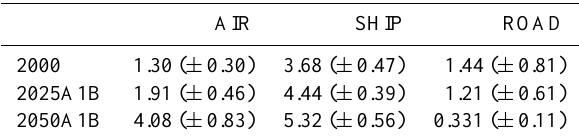
Table 3. Relative changes (%) in methane lifetime (integrated up to 50hPa) due to a 5% decrease in traffic emissions. Values are global annual averages given relative to the BASE simulation, and are scaled to 100% by multiplying with 20. Both the mean of the six models and the standard deviations (indicating the spread of the models) are given. Note that this table does not include the feedback effect of methane changes on its own lifetime.